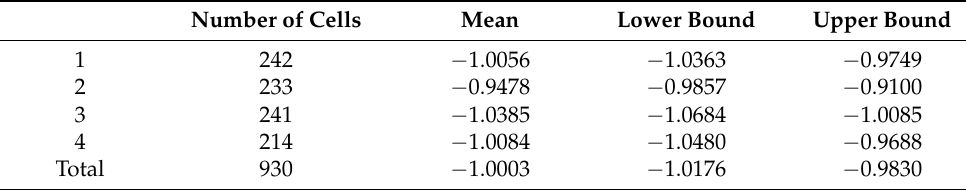
Table 2. Summary of heterochromatin (TH) values measured in chromosomes of Astyanax scabripinnis . Individuals 1 and 2 are male B+ and B−, respectively. Individuals 3 and 4 are females, B+ and B−, respectively. Confidence interval for mean: p > 95%.